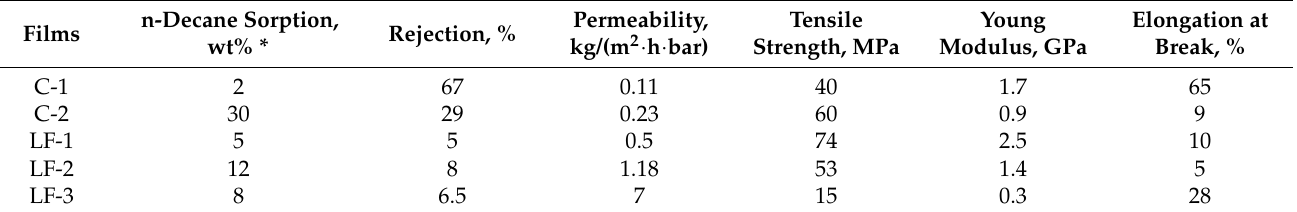
Table 2. Ethanol permeability and Orange II rejection for water activated membranes, mechanical characteristics and sorption data of n-decane by cellulose for dry